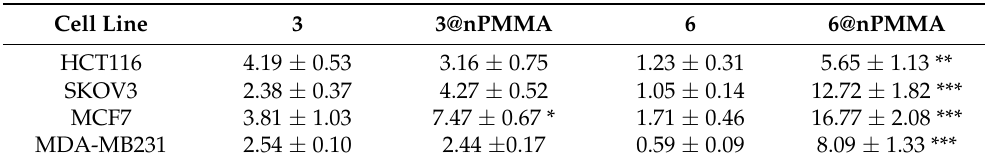
Table 2. IC 50 values (nM) obtained in HCT116, SKOV3, MCF7 and MDA-MB231 cells by the MTT assay following 24 h incubation with the free and nPMMA-bounded BODIPYs ( 3 and 6 ), 1 h irradiation and 24 h incubation in a drug-free medium (mean ± SD of 4/5 independent experiments; * p < 0.05, ** p < 0.01 and *** p < 0.001 vs. respective free BODIPY). Cell